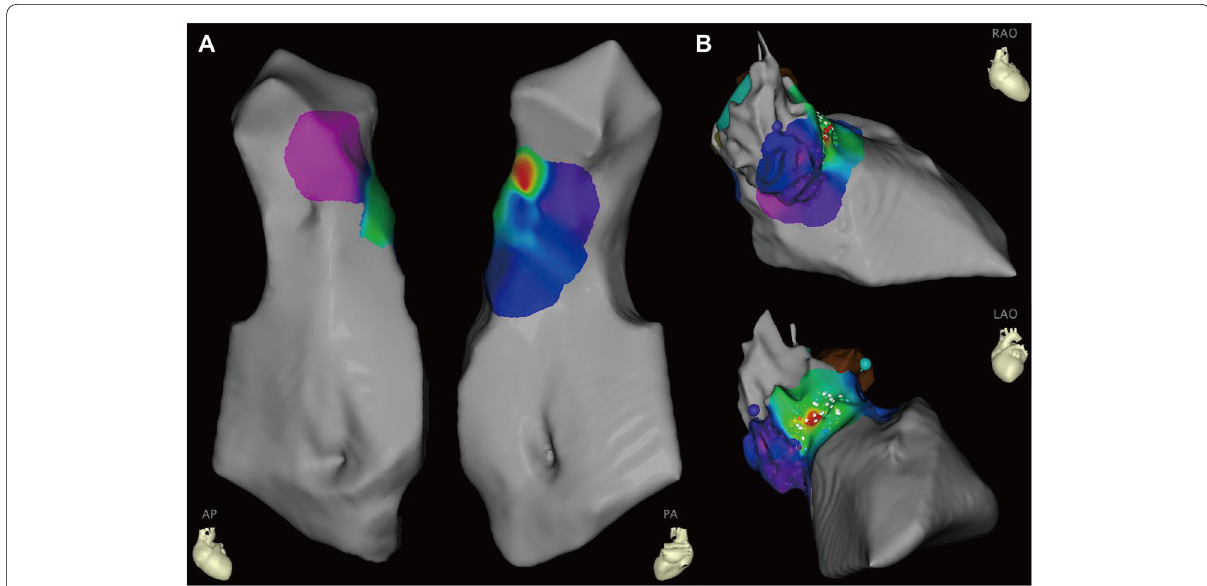
Fig. 3. Three‑dimensional electroanatomical mapping of RVOT and LVOT incorporated with anatomic shell mapping using intracardiac echocardiography. A. Three‑dimensional (3D) mapping of RVOT presented with antero‑posterior view (left) and postero‑anterior view (right) view. B. 3D mapping of LVOT presented with right anterior oblique (top) and left anterior oblique (bottom) view